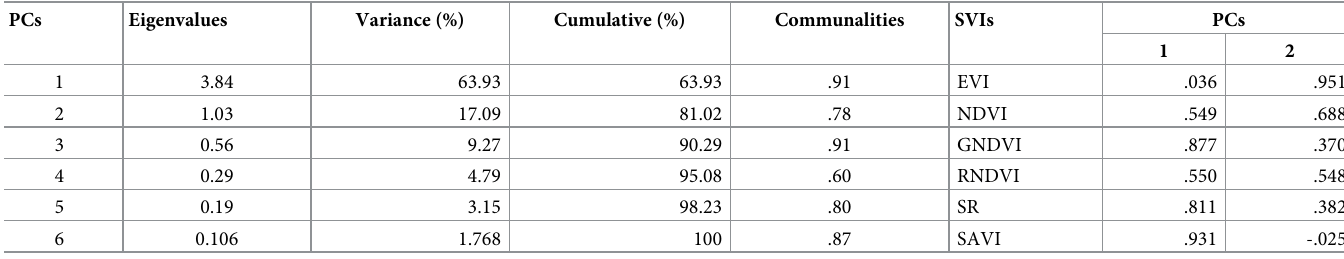
Table 4. Variance explained by principal components and loading of the vegetation indices of